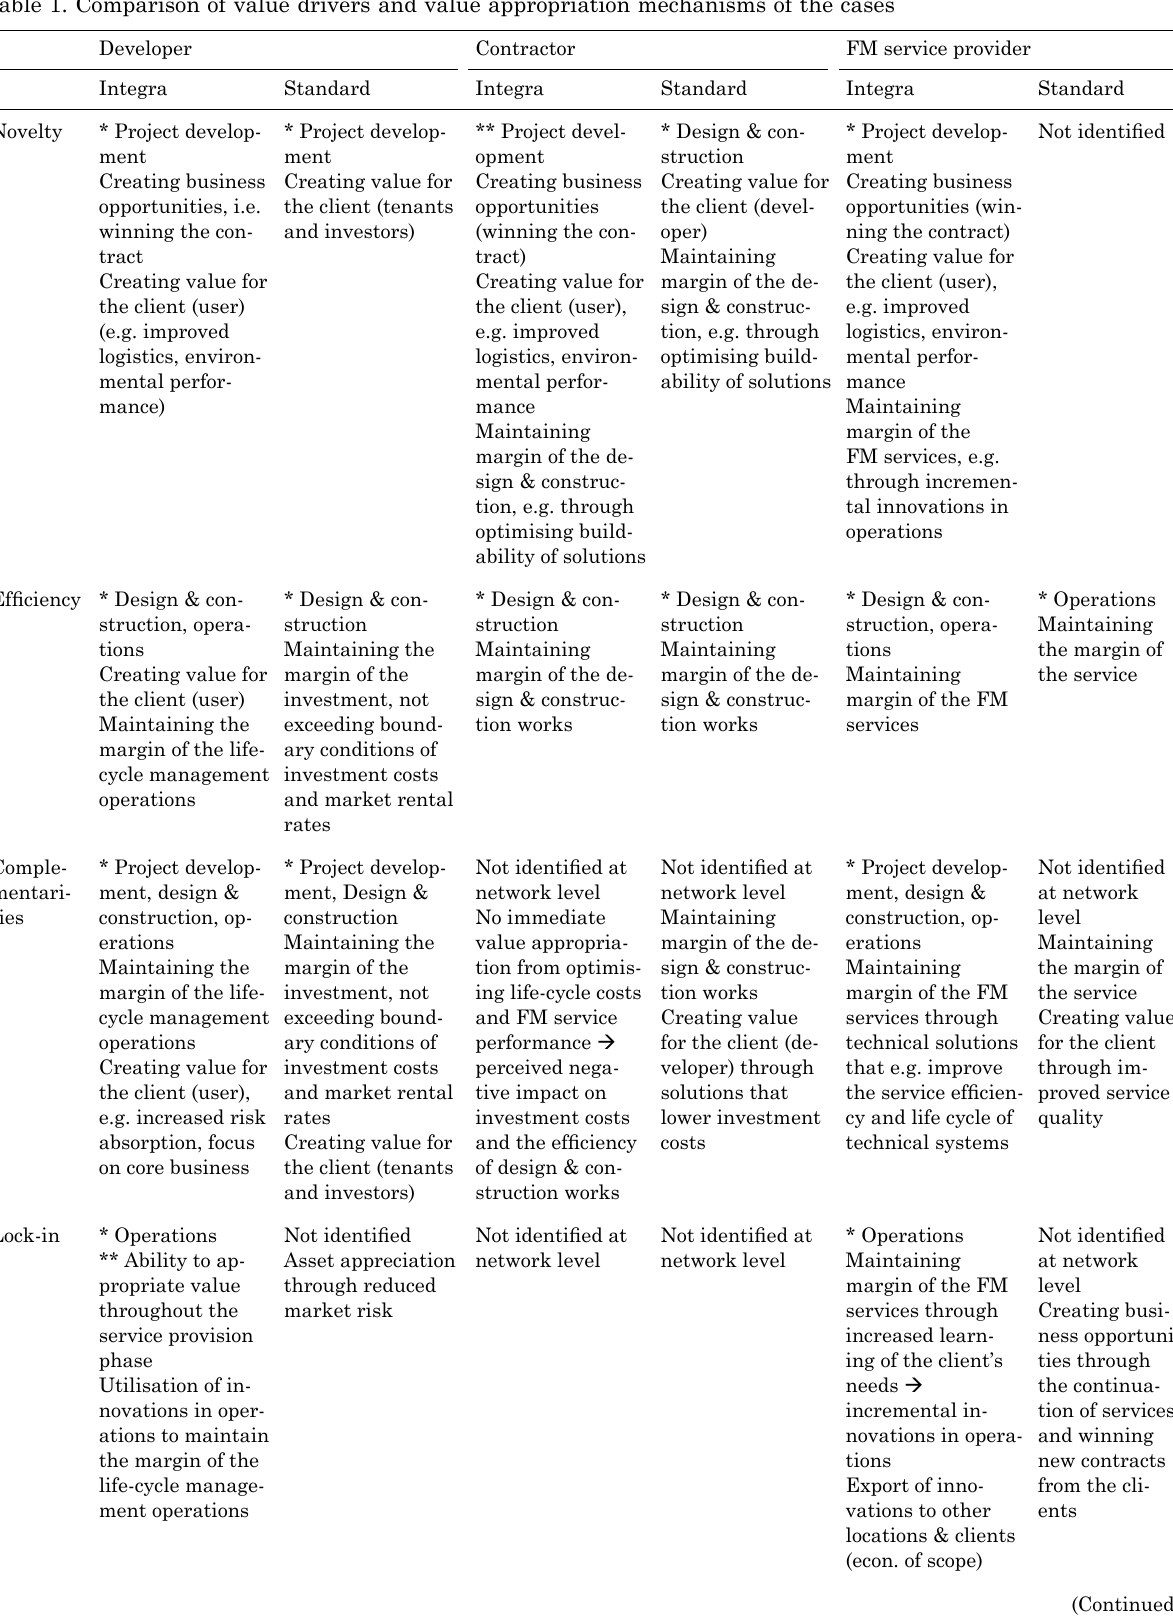
Table 1. Comparison of value drivers and value appropriation mechanisms of the cases